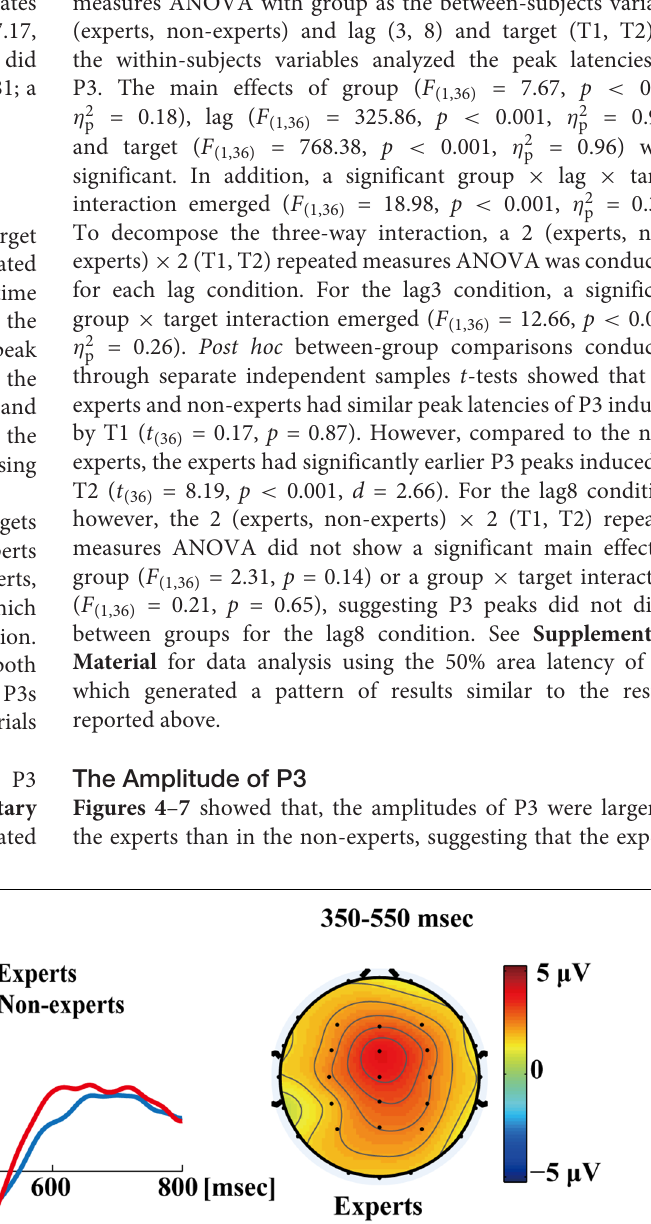
Frontiers in Human Neuroscience |